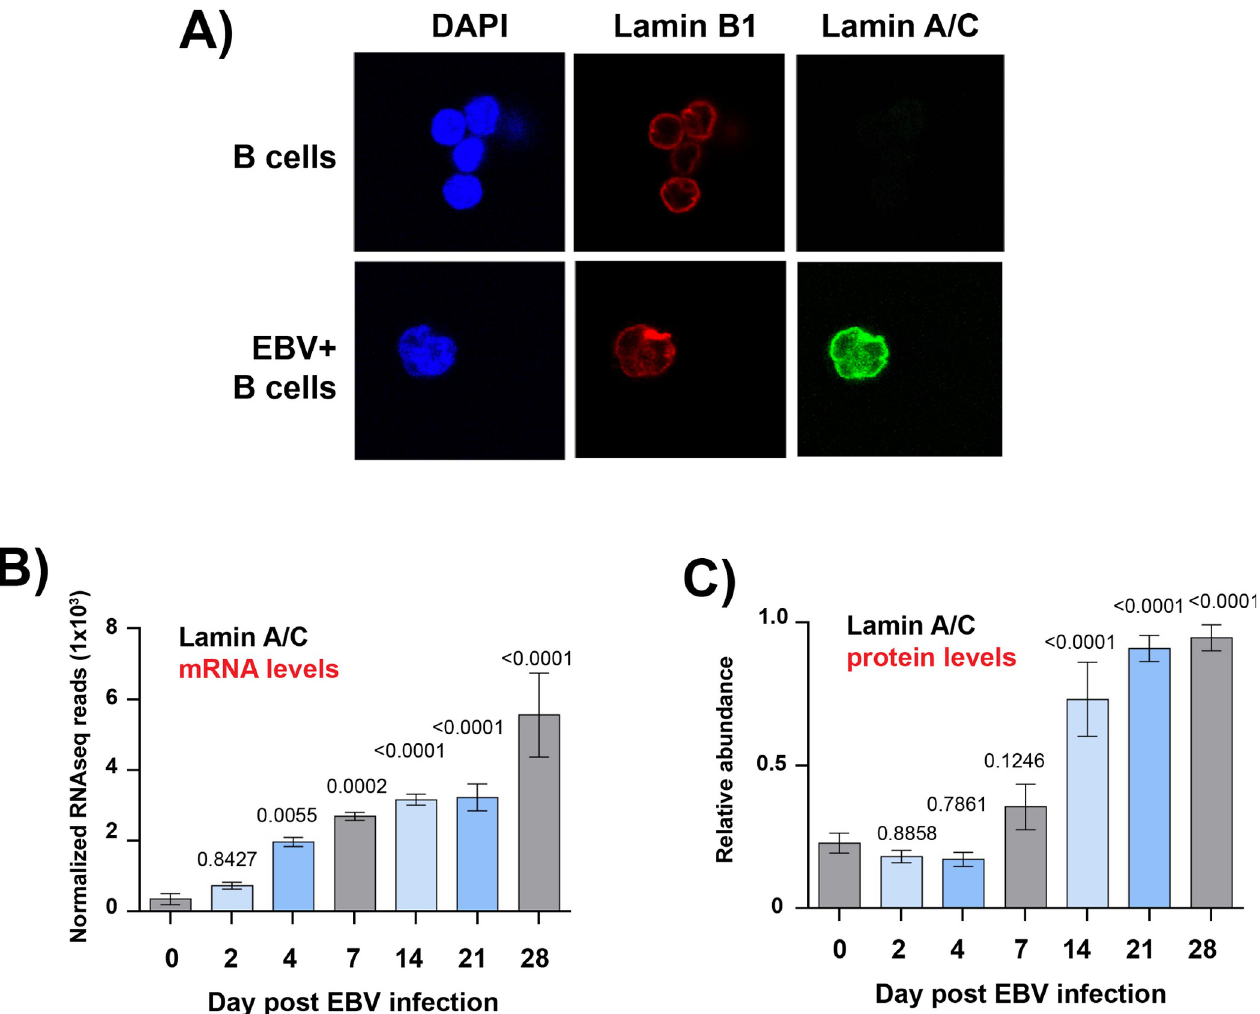
Fig 2. EBV infection of primary B cells induces the expression of lamin A/C. A) Immunofluorescence confocal microscopy analysis of B cells from a healthy donor immunostained with lamin B1 (red) and lamin A/C (green) antibodies and DAPI (blu). Top: control (uninfected) cells; bottom: 2 days post-infection with EBV viral particles. B) RNA-seq of primary B cells from 3 different healthy donors that were infected with EBV and collected at the indicated time points after viral infection. The plot shows the normalized reads of lamin A/C mRNA. The t test p values for each time point are indicated. C) Whole cell proteomic analysis of lamin A/C expression at the indicated time points following infection of primary human B cells as described in B. The plot shows the relative abundance of lamin A/C from 3 biological replicates, representing 12 human donors. The t test p values for each time point are indicated. N = 3, Mean ± SD. program ( Fig 2B ). Using proteomic datasets obtained from human primary B cells before and after EBV infection, we found that lamin A/C protein levels mirrored the surge in lamin A/C mRNA expression, reaching a ~5-fold increase in the same time frame ( Fig 2C ). Taken Type III latency program induce and maintain lamin A/C expression in B cells.